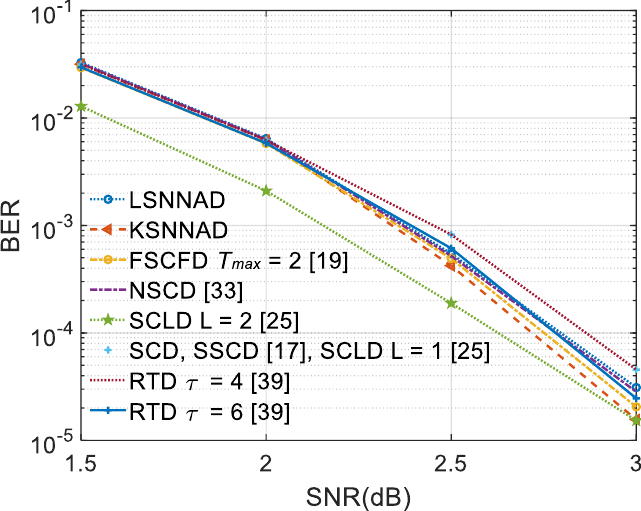
Figure 16. Decoding results of different decoding schemes.